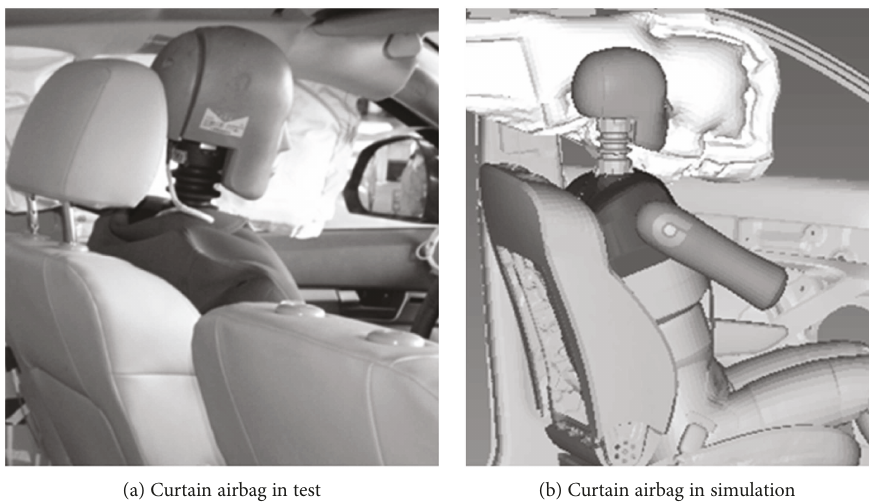
Figure 5: Curtain airbag in the test and